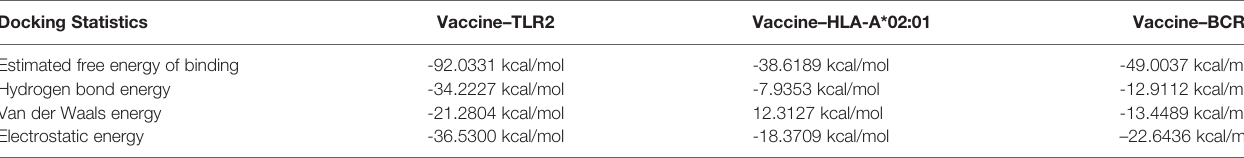
TABLE 5 | Docking energy of the vaccine with TLR2 and HLA-A*02:01. Docking